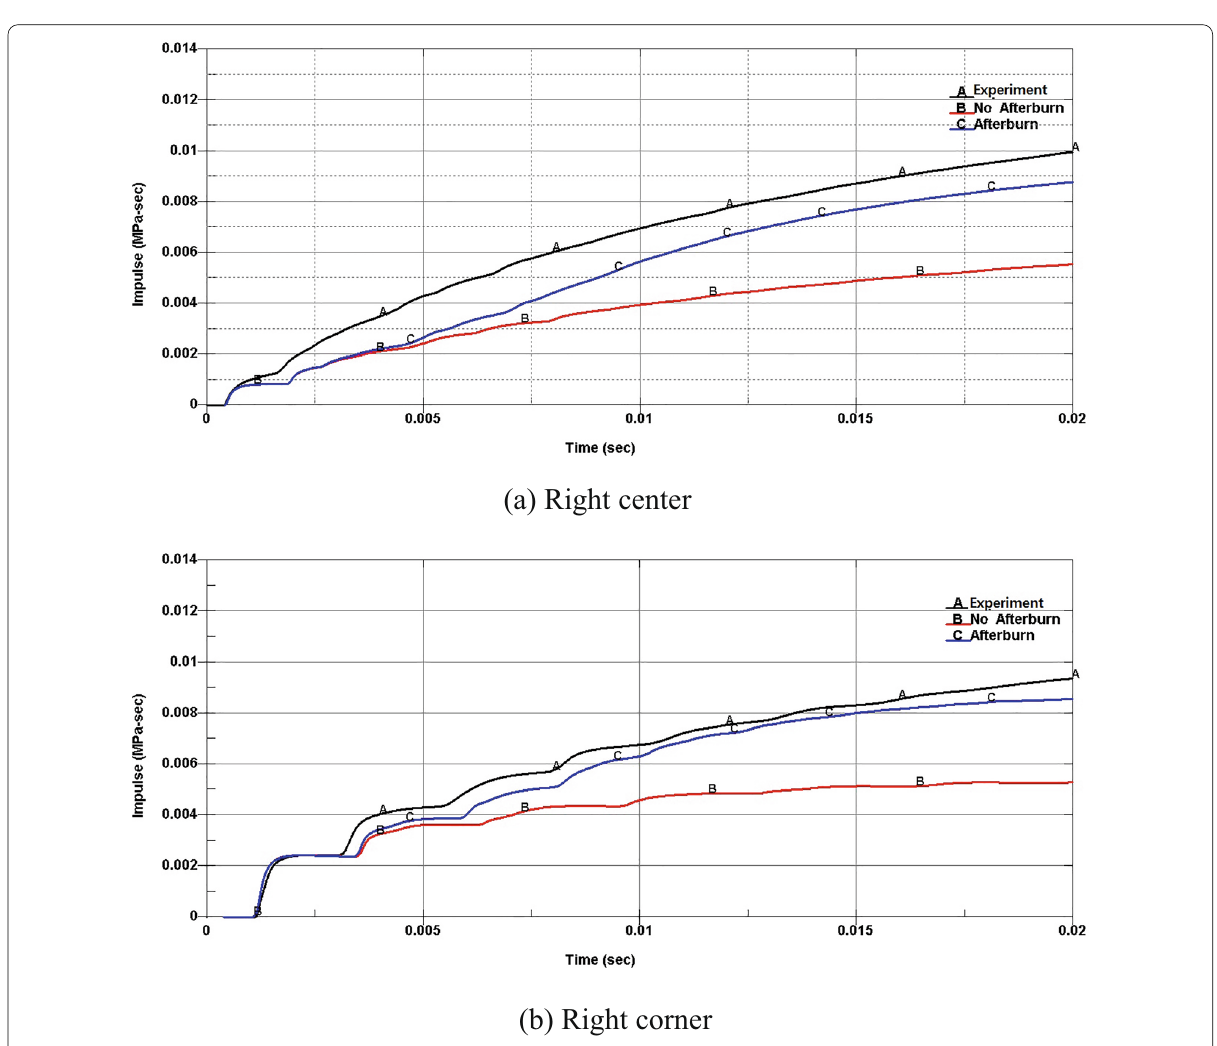
Fig. 22 Impulse comparison over Time.